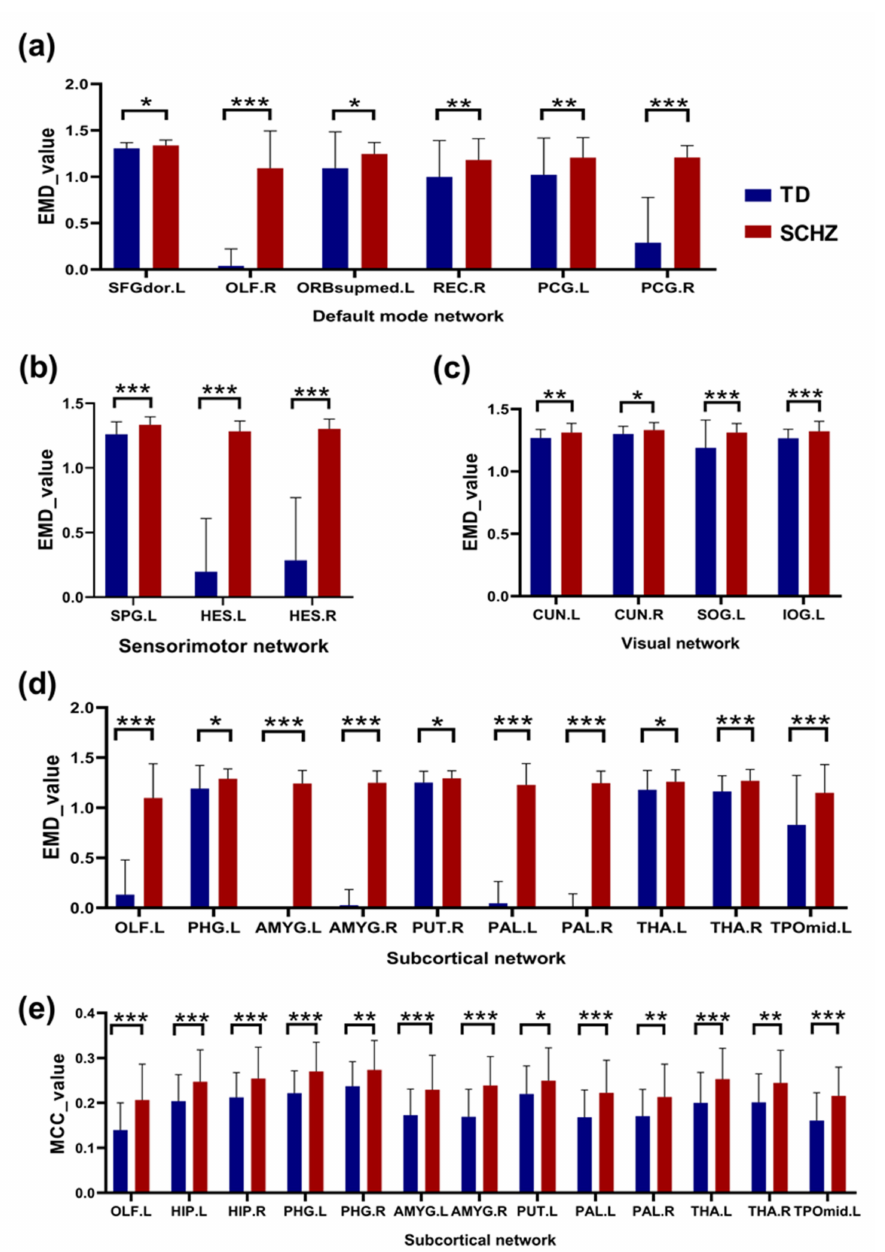
Figure 8. Differences between normal controls and patients with schizophrenia (SCHZ) in terms of node vulnerability. Panels ( a – d ) represent the damaged brain areas detected in the default mode network, sensorimotor network, visual network and subcortical network, respectively, of the schizophrenia patients according to the entropy of the multiplex degree (EMD). Panel ( e ) represents the damaged brain areas in the subcortical network of schizophrenia under the multilayer clustering coefficient index (MCC). Asterisks indicate the difference between the groups and were divided into three cases: * 0.01 < p < 0.05, ** 0.001 < p < 0.01, and *** p =